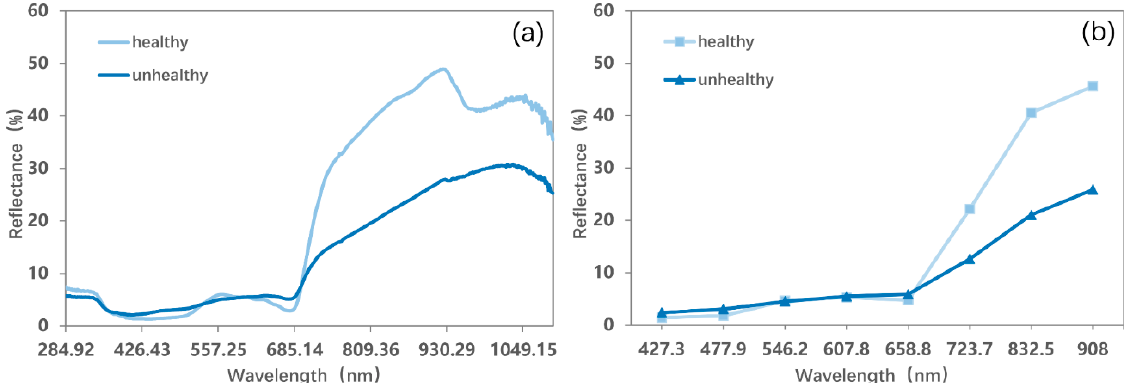
Figure 8. ( a ) Field-measured spectra and ( b ) endmember spectra for healthy and unhealthy mosses.